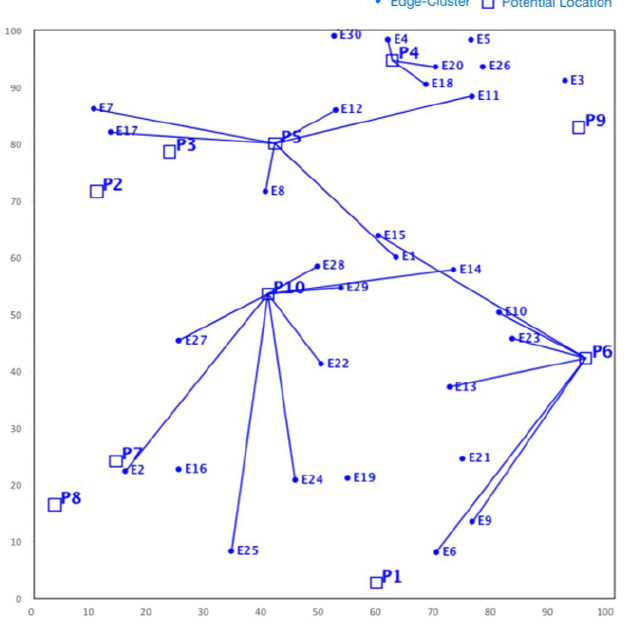
Figure 14. Output layout for SONG at e avg v = 77.31 units, τ avg v 323.1